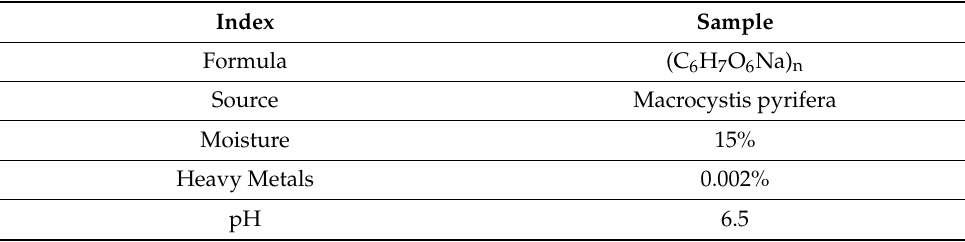
Figure 3. Experimental setup for resonant column test of a soil sample.